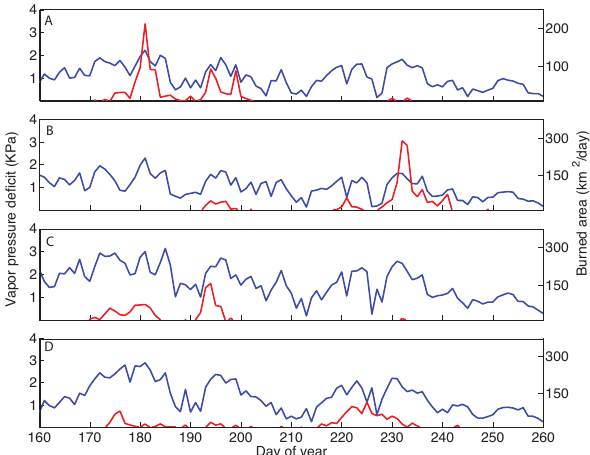
Figure 7. Time series of VPD and burned area for four large fires in 2004: (A) Boundary, (B) Dall City, (C) Winter Trail, and (D) Billy Creek. Daily VPD are shown with the blue line, daily burned area (in km 2 per day) with the red line, and fire duration with the black line near the top of each panel.